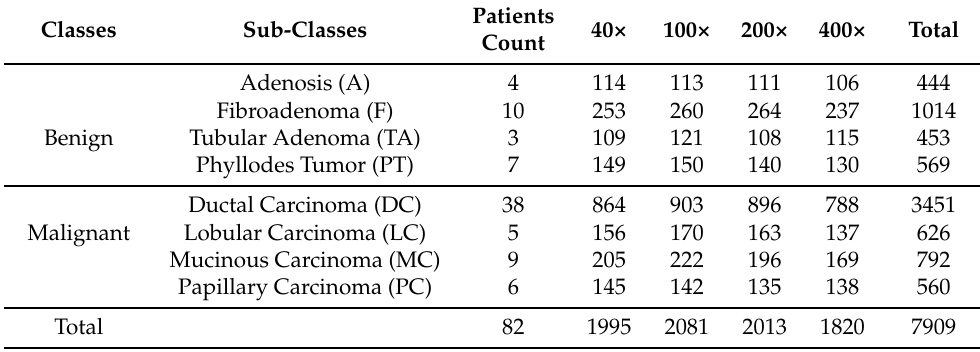
Table 2. Description of the BreakHis dataset for